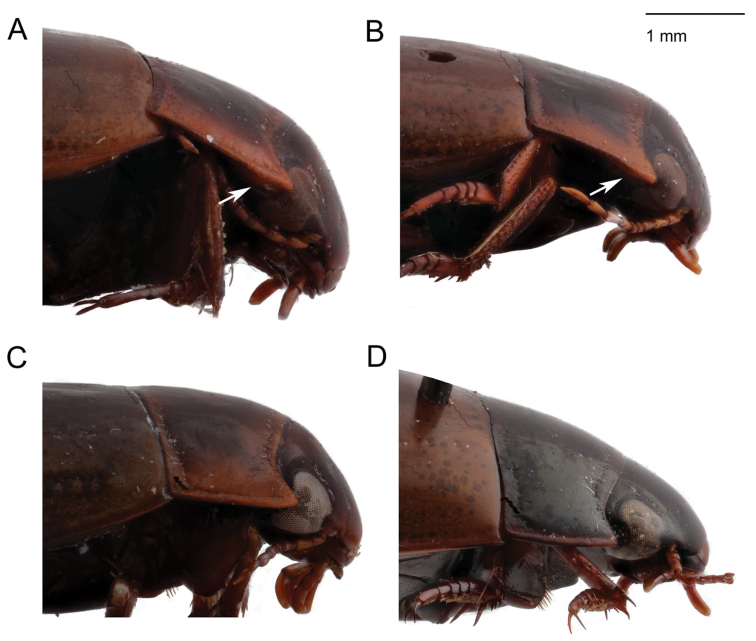
Agabus spp., hypomeron in lateral view AA.
sjostedtiBA.
dytiscoidesCA.
anguluverpus sp. nov. DA.
raffrayi. White arrows indicate hypomeron.